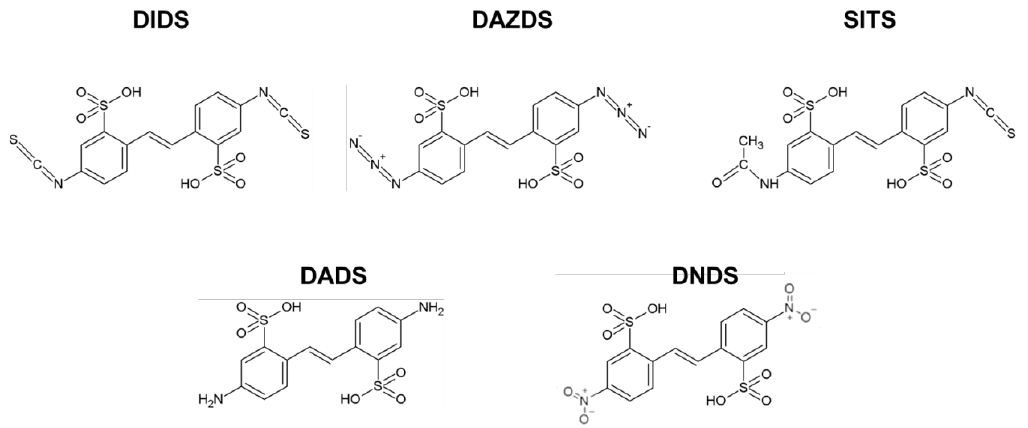
Figure 1. Chemical structures of DIDS characterized by two isothiocyanate groups and its derivatives DAZDS including two azido groups, SITS including isothiocyanate and acetamide group, DADS including two amino groups and DNDS including two nitro groups.